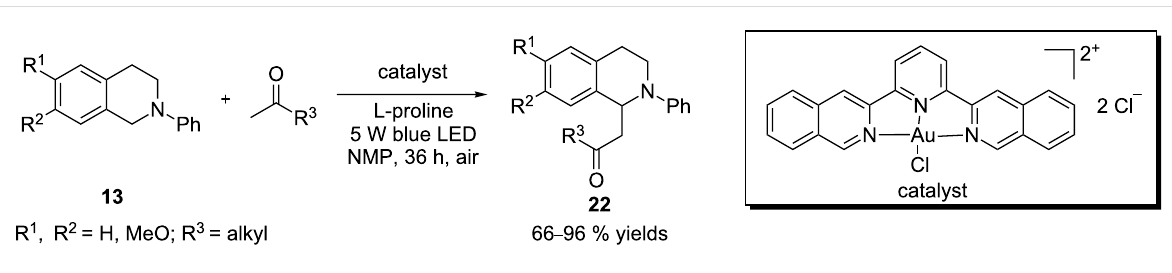
Scheme 9: Merging Au-based photoredox catalysis and Lewis base catalysis for the Mannich